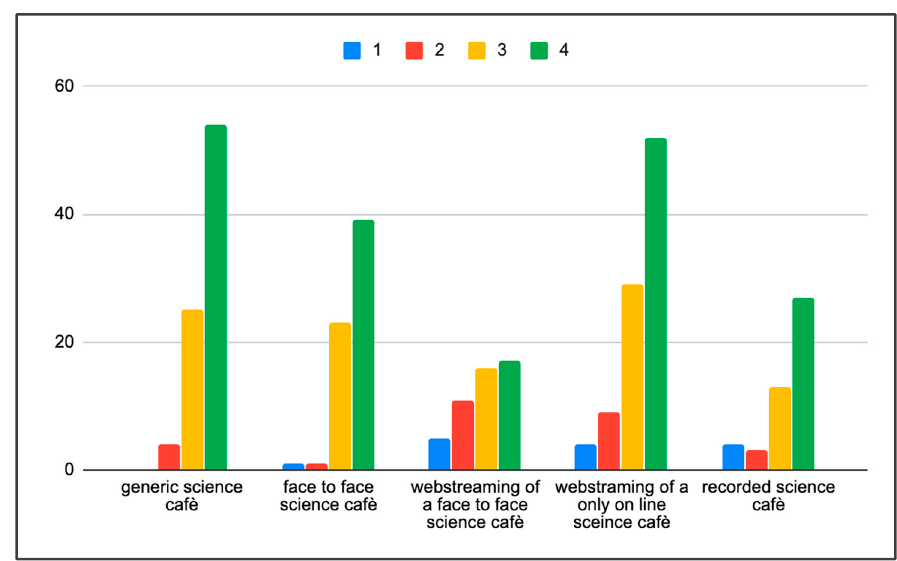
Figure 5. Approval of the various modalities of science Café from 1 (not good) to 4 (optimum). By analyzing the data, we can say that about 1/4 of the audience of online science cafés has never attended a live version.